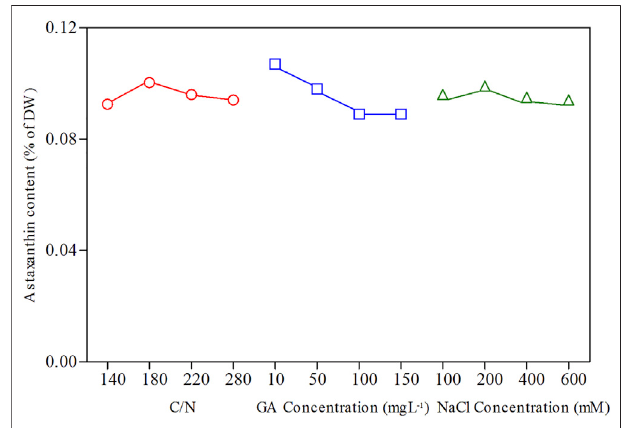
FIGURE 5 | Orthogonal experimental effect curves for astaxanthin content of C. zo fi ngiensis. All treatment groups were performed in Erlenmeyer fl